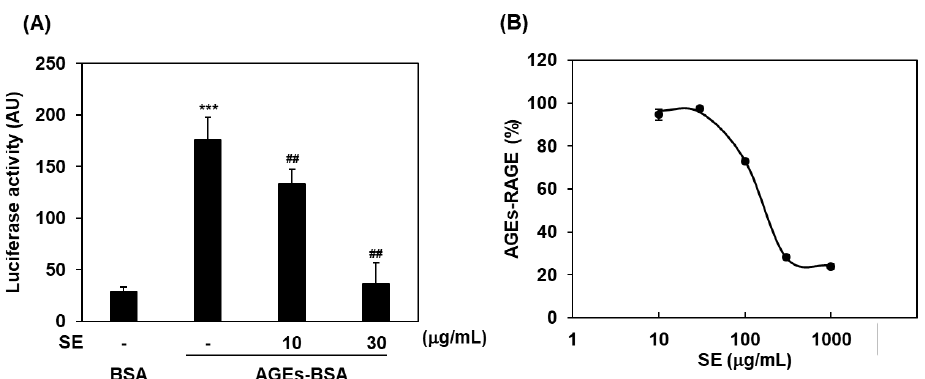
Figure 1. Inhibitory effects of SE on RAGE intracellular signaling and AGEs–RAGE interac- tions. ( A ) RAGE-dependent NF- κ B activity assay. Glyceraldehyde-derived AGEs-BSA (AGEs-BSA) (100 µ g/mL), non-glycated BSA control (BSA), and SE (10 or 30 µ g/mL) were used. Data